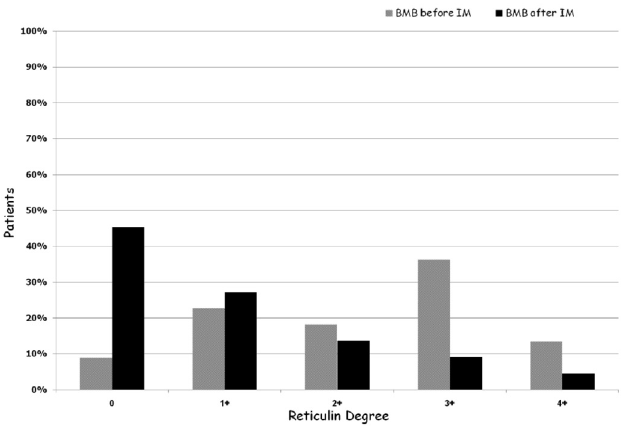
FIGURE 4 - BMB distribution of CML patients included in the study, according to Fibrosis/Reticulin degree (Gomori stain).